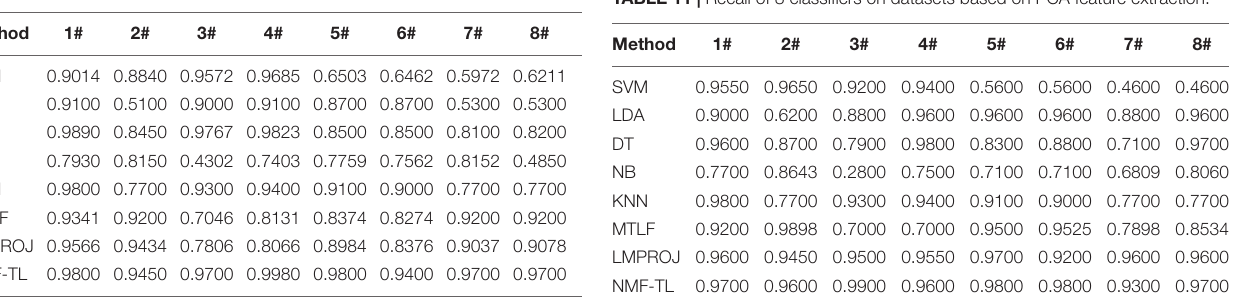
TABLE 7 | F1_score of 8 classifiers on datasets based on PCA feature extraction.